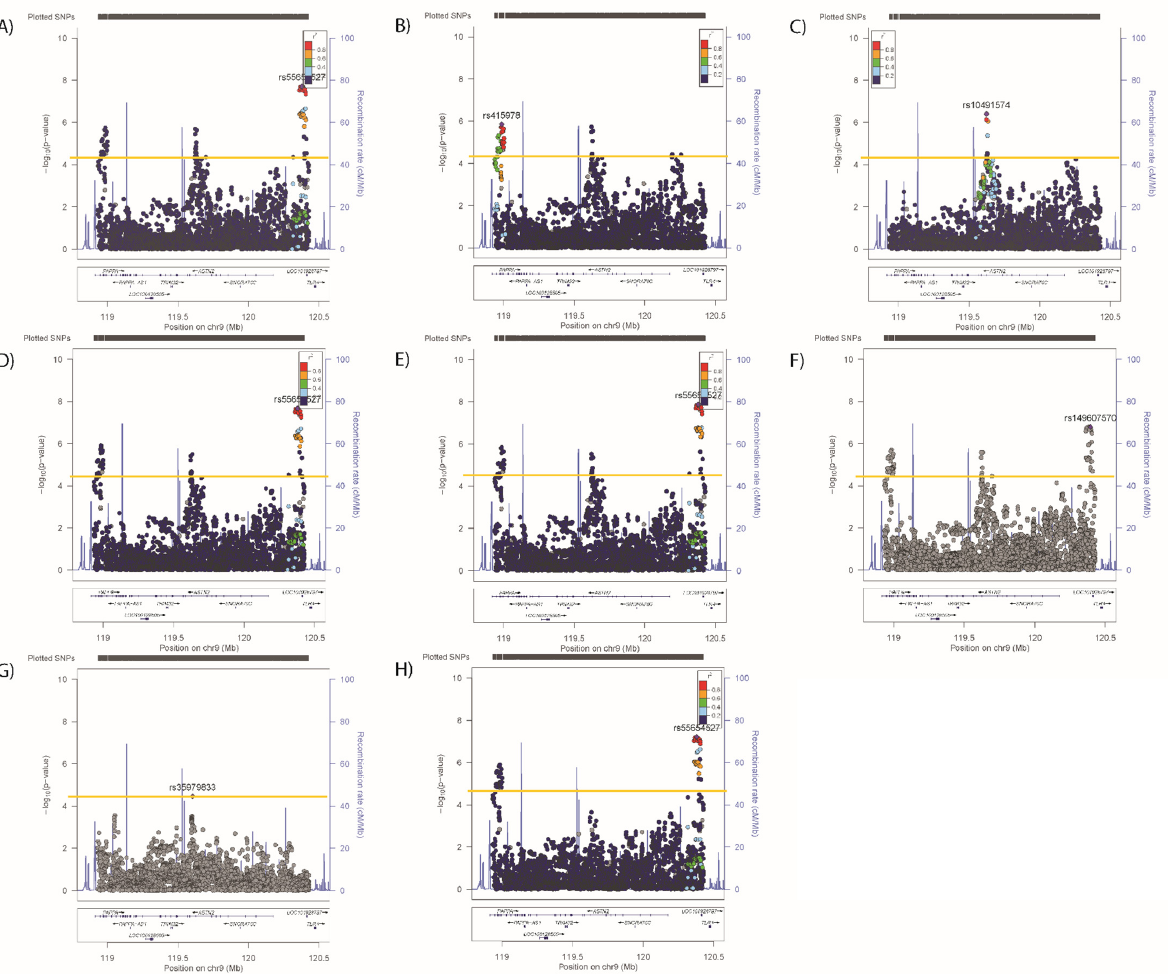
Figure 4. Regional plots for associations between ASTN2 and ( A ) BMI, ( B ) adjusted for the primary SNP for BMI, ( C ) primary and secondary SNPs for BMI, primary SNP for ( D ) SBP/DBP, ( E ) WHRadjBMI, ( F ) neuroticism, ( G ) anhedonia, and ( H ) mood instability. Significance was set at p -value < 5.45 × 10 − 5 or − log10 > 4.26 (Horizontal yellow line). LD (r2) with the lead SNP are indicated by colour. Grey indicates that there is no LD information available.